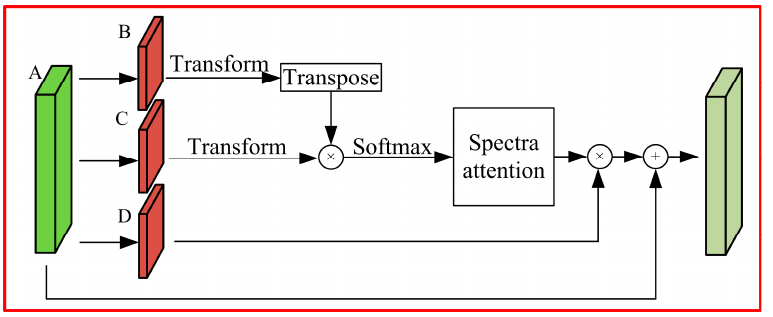
Figure 3. Spatial attention mechanism.